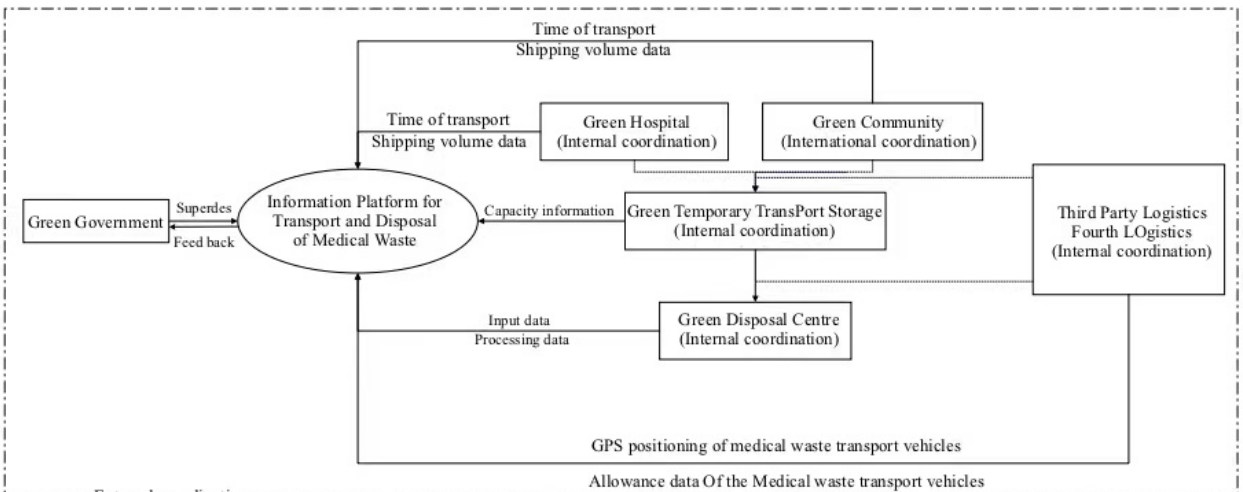
Figure 1. Medical waste management model based on green governance principles.